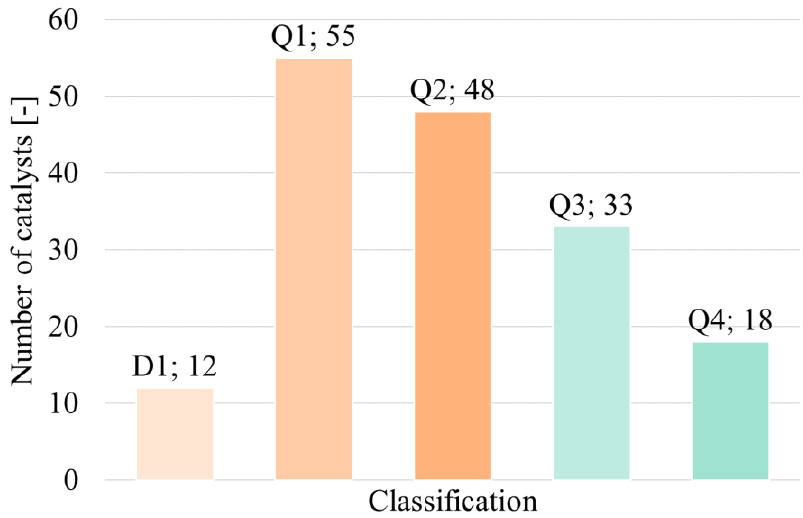
Figure 10. Effect of increasing number of known parameters for MIRA number.